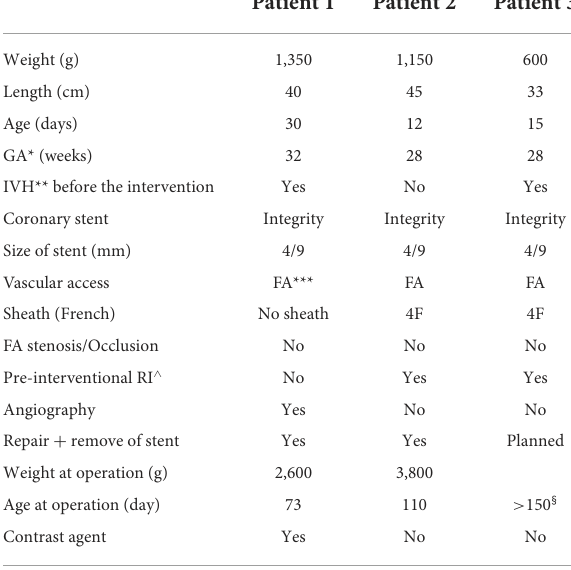
TABLE 1 Summary table presenting patient characteristics, size of sheath and the follow